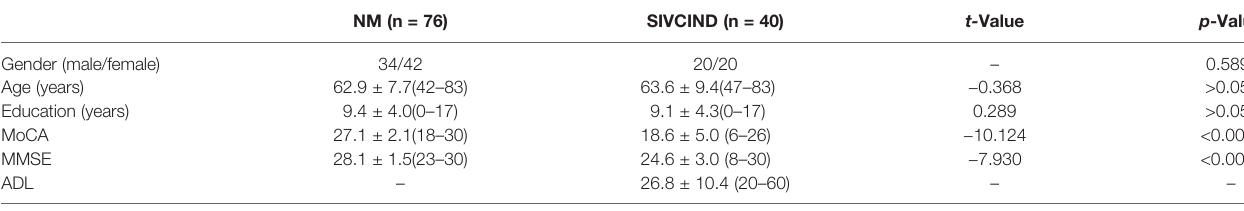
Data are expressed as mean ± SD (range from min – max). MoCA, Montreal Cognitive Assessment; MMSE, Mini-Mental State Examination; ADL, Activities of Daily Living Scale; NM, normal controls; SIVCIND, subcortical ischemic vascular cognitive impairment with no dementia. a The p-value was acquired by Pearson ’ s chi-squared test. b The p-value was acquired by two-sample